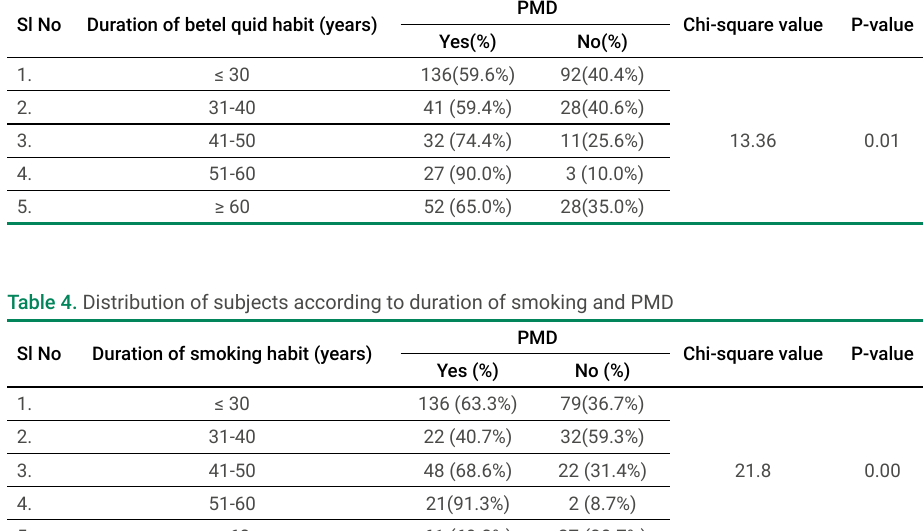
Table 3. Distribution of subjects according to duration of betel quid chewing and PMD. Sl No Duration of betel quid habit (years)